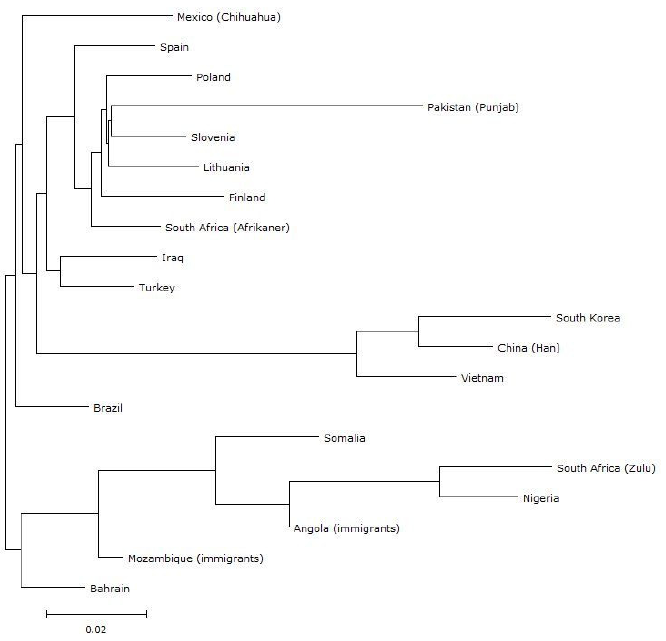
Figure 1. Phylogenetic tree (NJ) of the Polish population and 19 other reference populations based on FST distances.